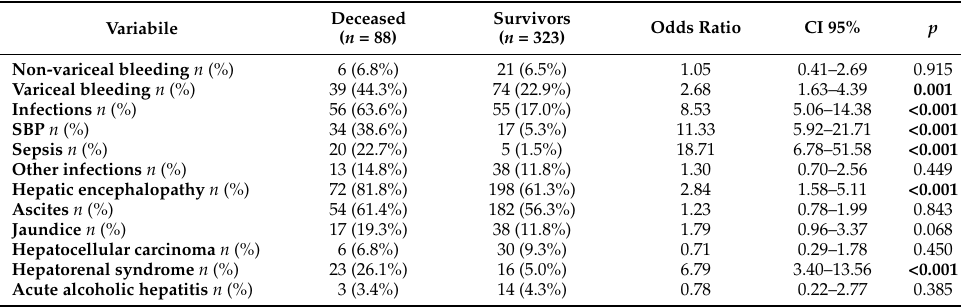
Table 4. Risk of death depending on complications—multiple